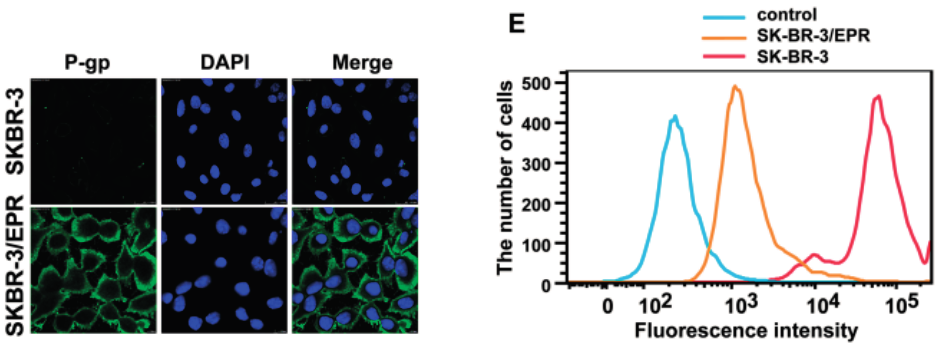
Figure 2. P-glycoprotein is upregulated in SK-BR-3/EPR cells. ( A ) Quantitative PCR analysis of expression of MDR1, MRP1, BCRP mRNA in SK-BR-3 and SK-BR-3